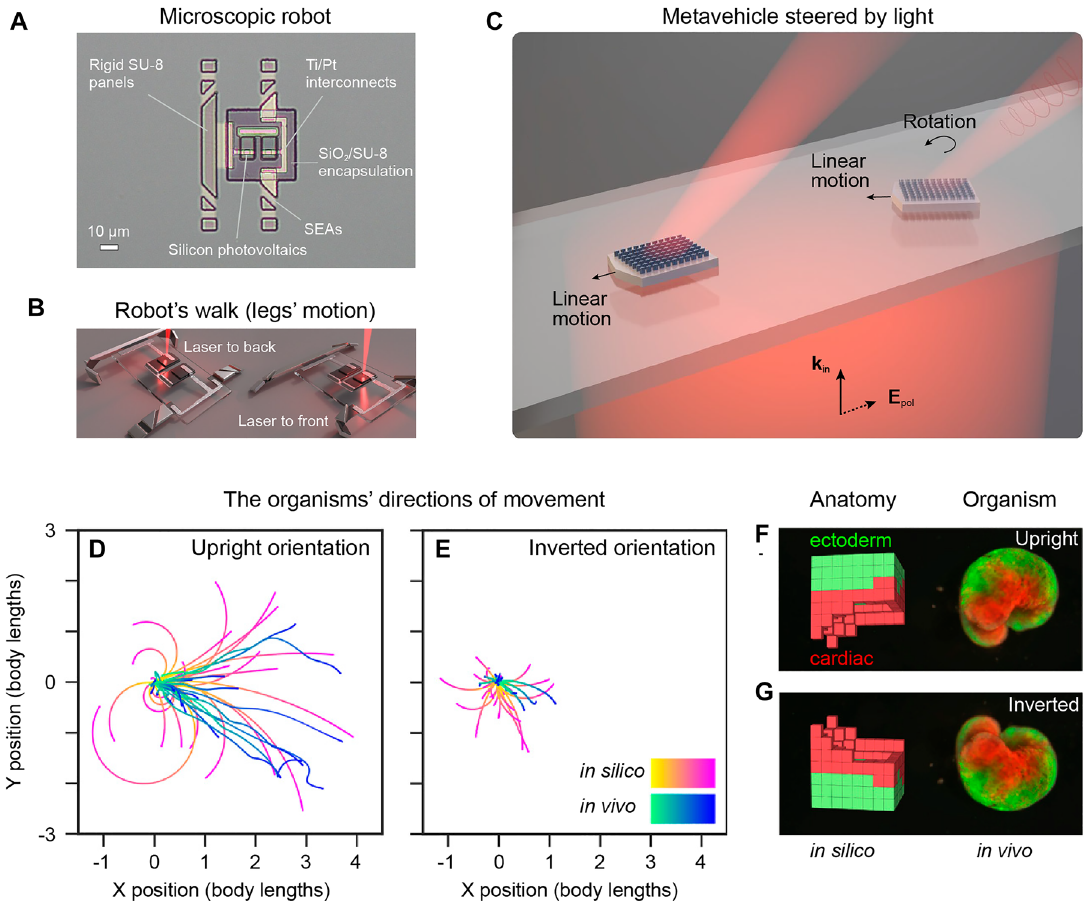
Figure 9: Toward embodied intelligence in microscopic